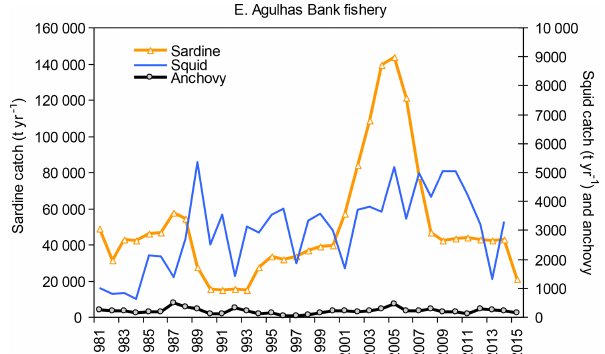
Figure 8. Time series of annual catches for leading fisheries in the eastern Agulhas Bank (outer domain covered by, Figs. 1a and 2a); this is the basis for results in Table 2.